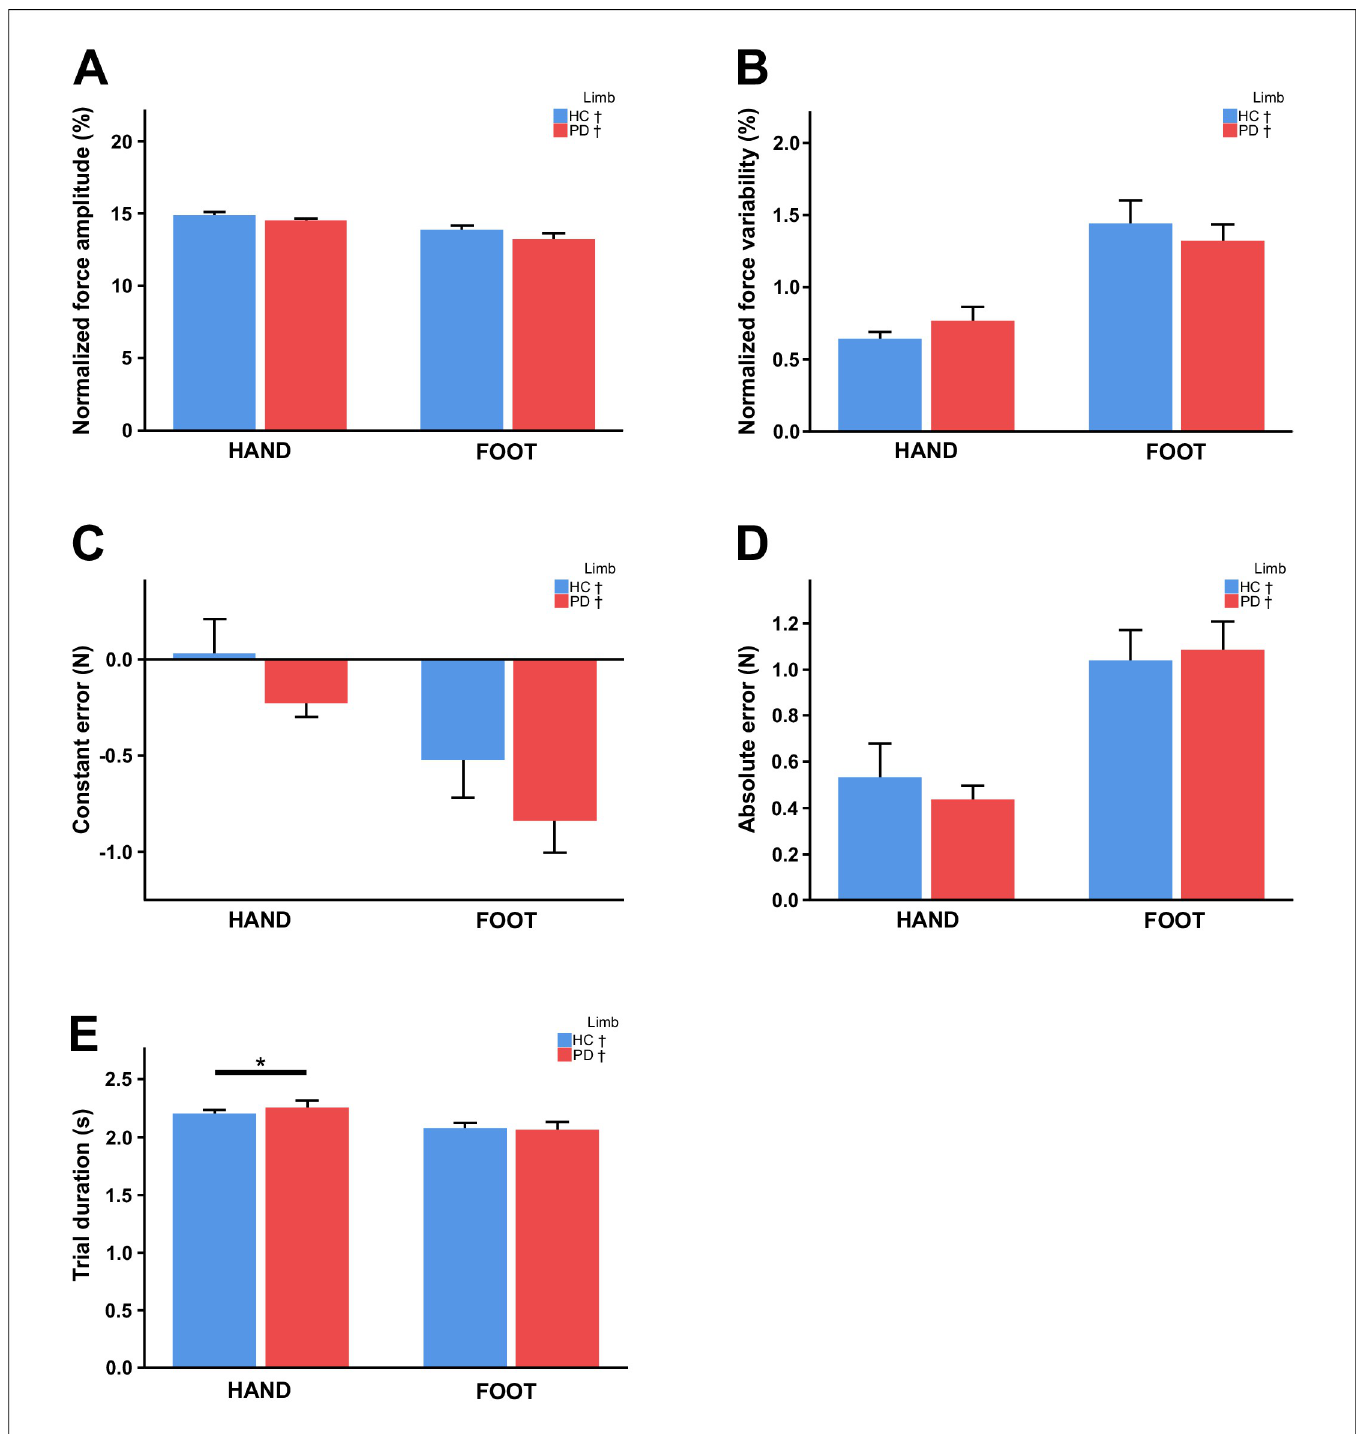
Fig 2. Bar graphs represent task performance for each group and limb (mean ± 1 SE). (A) Normalized force amplitude, (B) SD of the normalized force amplitude, (C) constant error, (D) absolute error, (E) trial duration. Asterisks indicate significant group effects at p < 0.05. Obelisks indicate significant limb effects at p < 0.05. Abbreviations: HC = healthy controls, PD = Parkinson’s disease.